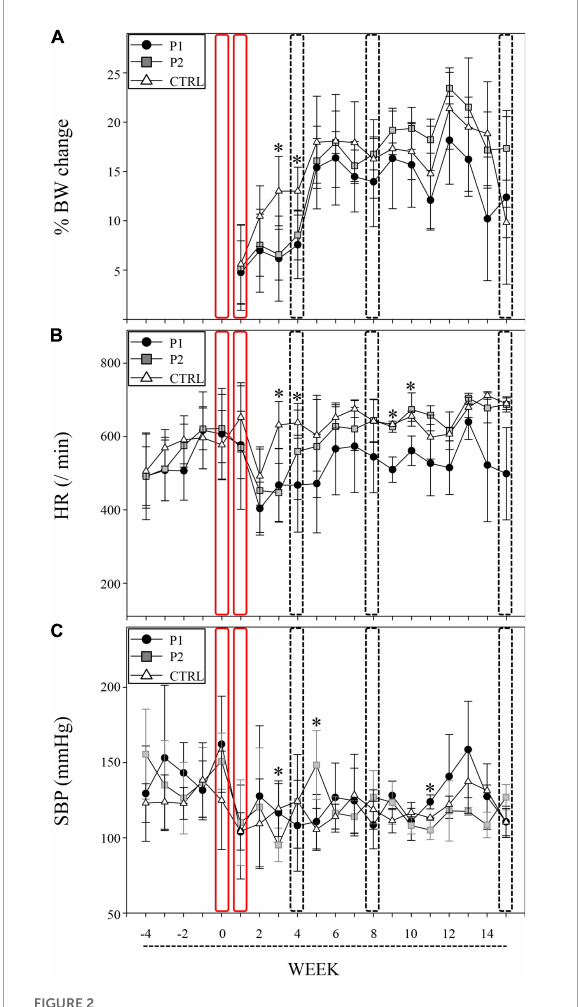
FIGURE2 nAChR α 3 peptides induced autonomic dysfunction with poor BW gain. Immunizations of nAChR α 3 were performed at week 0 and 1 (red frame), and sacrifices were performed at week 4, 8, and 15 (frame of dotted line). Data are expressed as mean ± standard deviation. Asterisks denote statistical significance level ( Supplementary Data 2 ). (A) Serial weight changes, (B) heart rate ( HR, /min ) , and (C) systolic blood pressure (SBP, mmHg) in immunized and control (CTRL) mice. Filled circles represent P1-immunized mice, gray squares represent P2-immunized mice, and open triangles represent CTRL